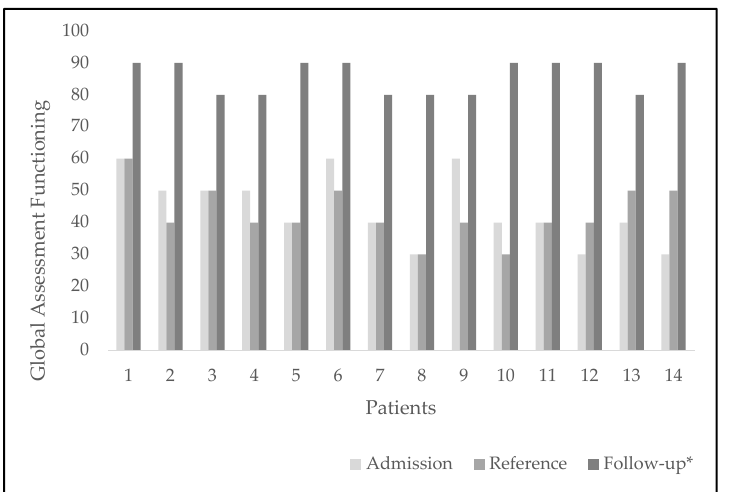
Figure 2. Global assessment functioning of every patient with time. Comparison of GAF values at three points: upon admission to the CED, at reference to monitoring, and at the end of follow-up. * GAF scores were significantly higher at follow-up, than at referral to monitoring, p =